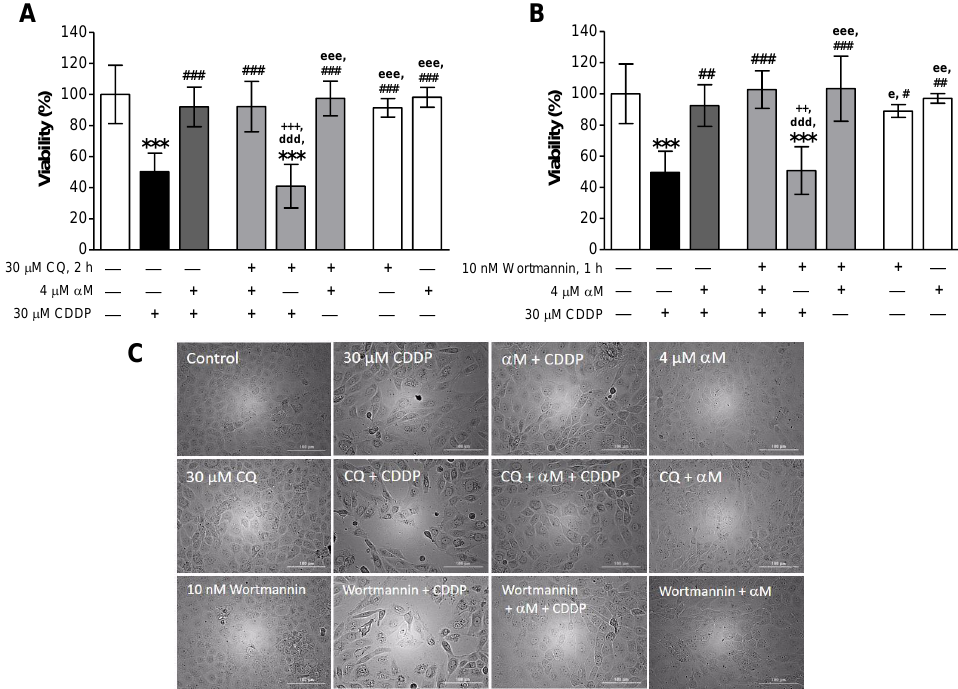
Figure 9. E ff ect of autophagy inhibition on the protection induced by α M vs. CDDP. LLC-PK1 cells were pretreated with ( A ) 30 µ M chloroquine (CQ) for 2 h, as an inhibitor of degradation of cargo in the final autophagy phase, or ( B ) 10 nM wortmannin for 1 h and during the experiment, as an inhibitor of phosphoinositide 3-kinase (PI3K) in the initial autophagy phase induction. After pre-treatment, the cells were co-incubated with 4 µ M α M and / or 30 µ M CDDP for 24 h. Cell viability was determined, and ( C ) representative micrographs were taken. The data are presented as mean ± SD, n = 4–6. *** p < 0.001 vs. control. ### p < 0.001, ## p < 0.01 and # p < 0.05 vs. cisplatin. +++ p < 0.001 and ++ p < 0.01 vs. ( α M + CDDP). ddd p < 0.001 vs. (stressor + α M + CDDP). eee p < 0.001, ee p < 0.01 and e p < 0.05 vs. (stressor+CDDP).